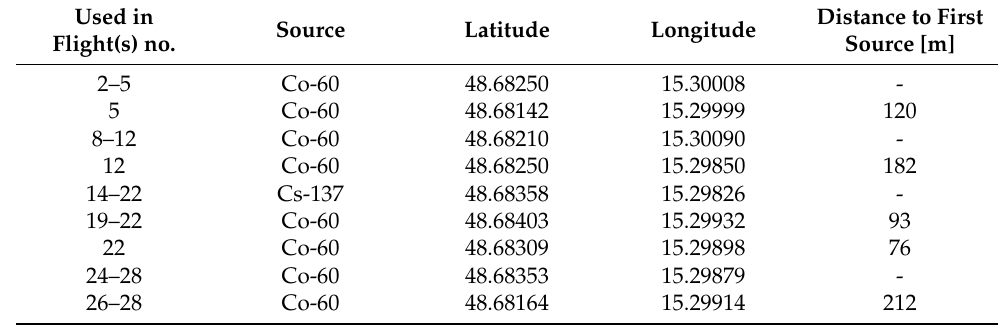
Table 2. Source positions.